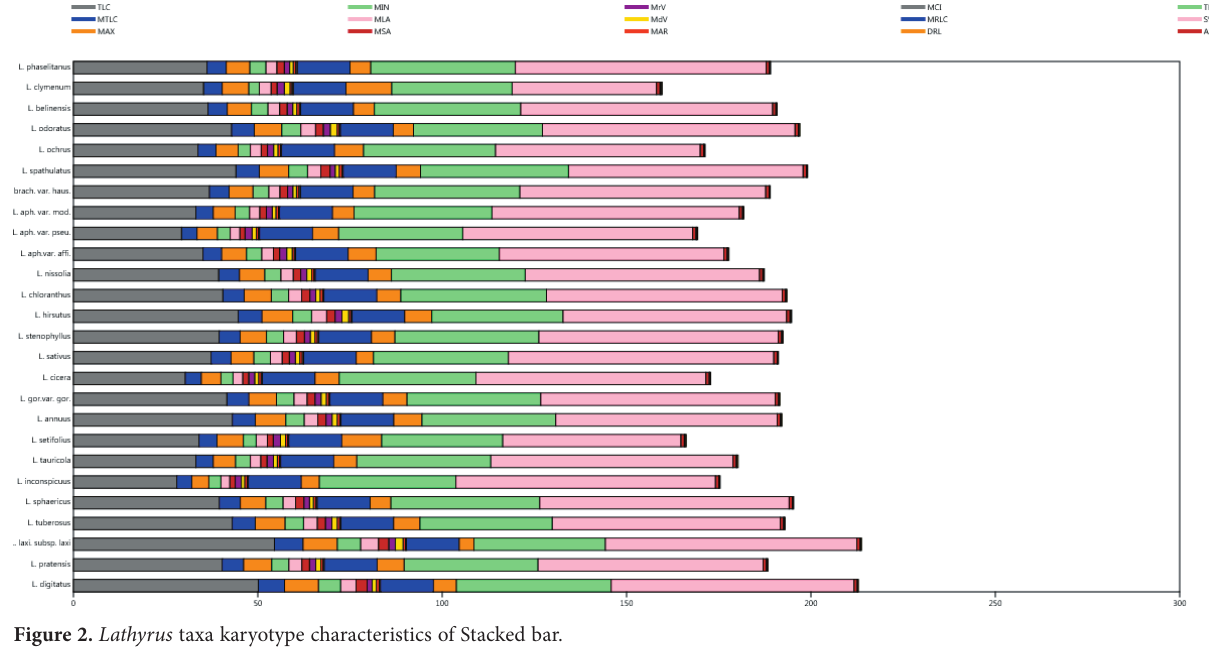
Figure 2. Lathyrus taxa karyotype characteristics of Stacked